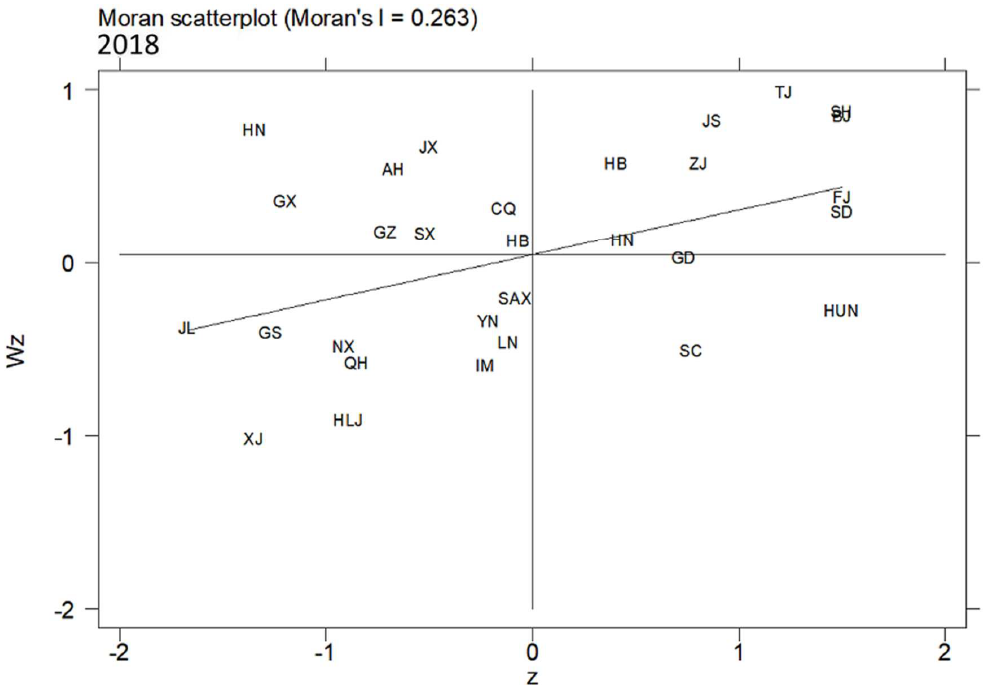
Figure 6. MSP map of ULGLE in 30 provinces in 2013.